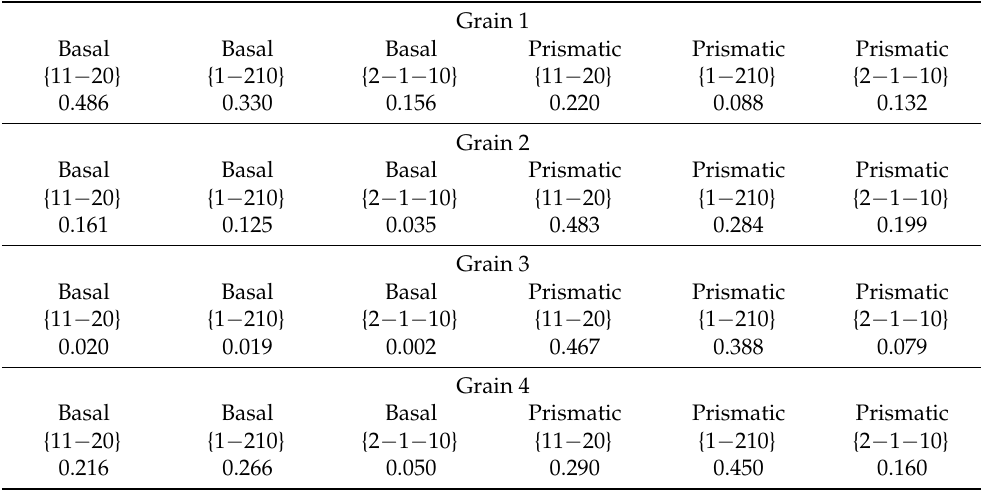
Table 1. Schmid factors of basal slip systems and prismatic slip systems in Grains 1–4.